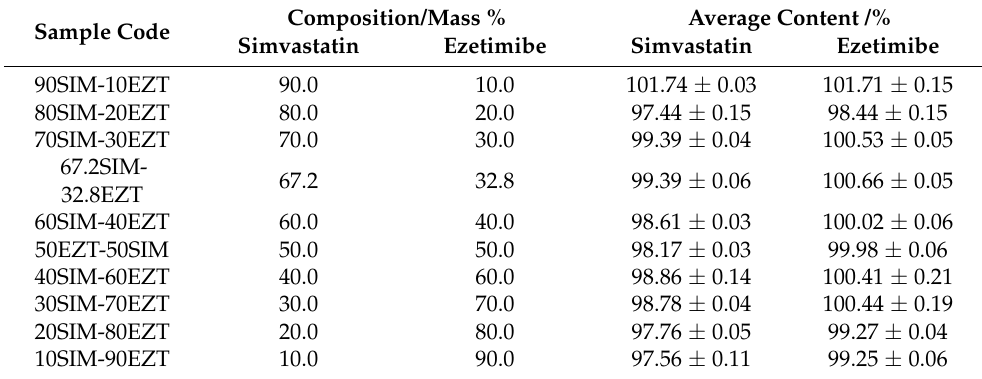
Table 1. Compositions of investigated SIM-EZT dispersions and APIs average content.